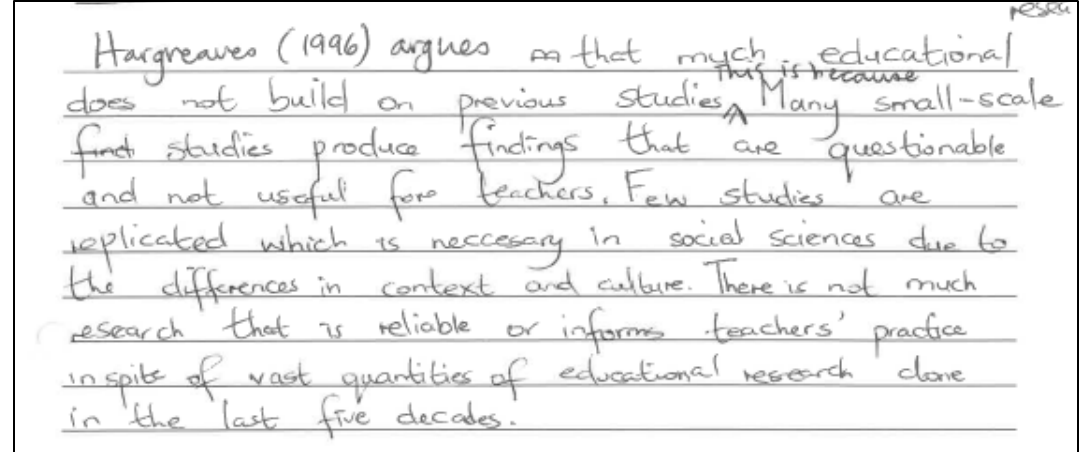
Figure 5 : Joint reconstruction of Hargreaves’